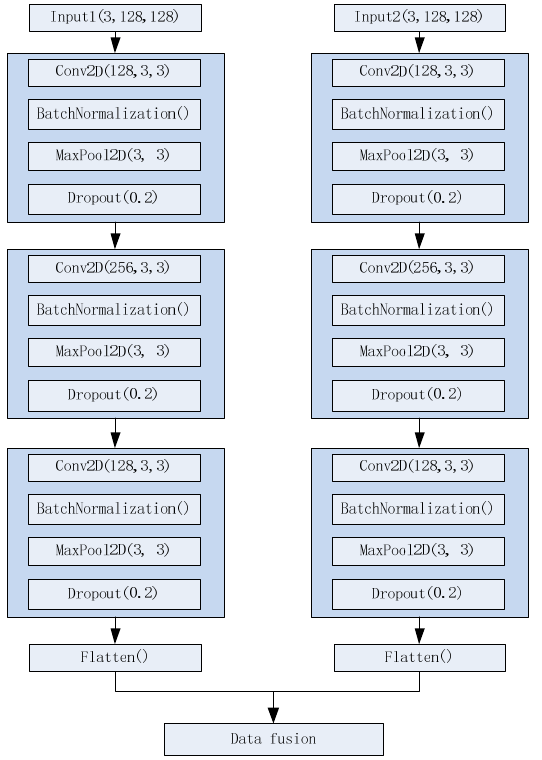
Figure 4. Structure of a custom convolutional neural network.